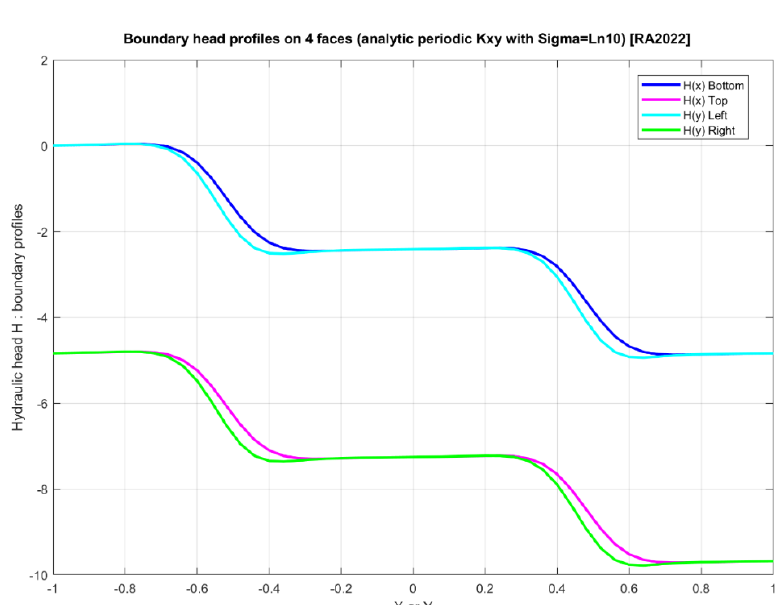
Figure 8. Plot of the 4 profiles of hydraulic head ℎ(𝑥) or ℎ(𝑦) along the 4 boundary faces of the square domain with periodic “exponential - cosine” permeability 𝐾(𝑥, 𝑦) for 𝜎 𝐿𝑛𝐾 = 𝐿𝑛10 ≈ 2.30 (high variability). It can be seen that the continuity of hydraulic head at the 4 corners of the square domain is ensured (more on this in the